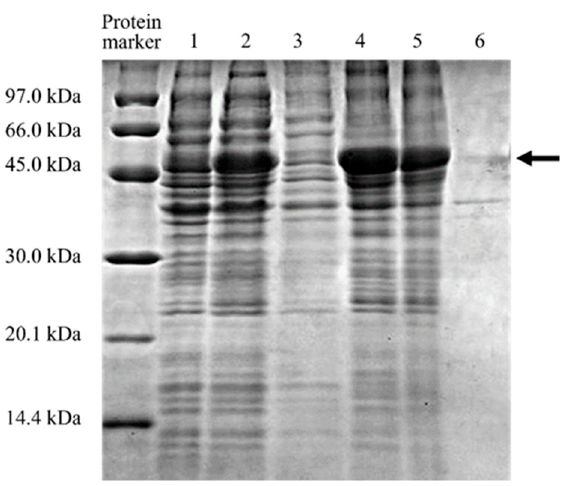
Figure 1. Expression and solubilization check of MD2-SBro protein. Lane 1: Before IPTG induction; Lane 2: After IPTG induction; Lane 3: Soluble fraction obtained after the sonication; Lane 4: Insoluble fraction obtained after the sonication; Lane 5: Soluble fraction obtained after the solubilization; Lane 6: Insoluble fraction obtained after the solubilization. The band corresponding to MD2-SBro is indicated by the arrow.